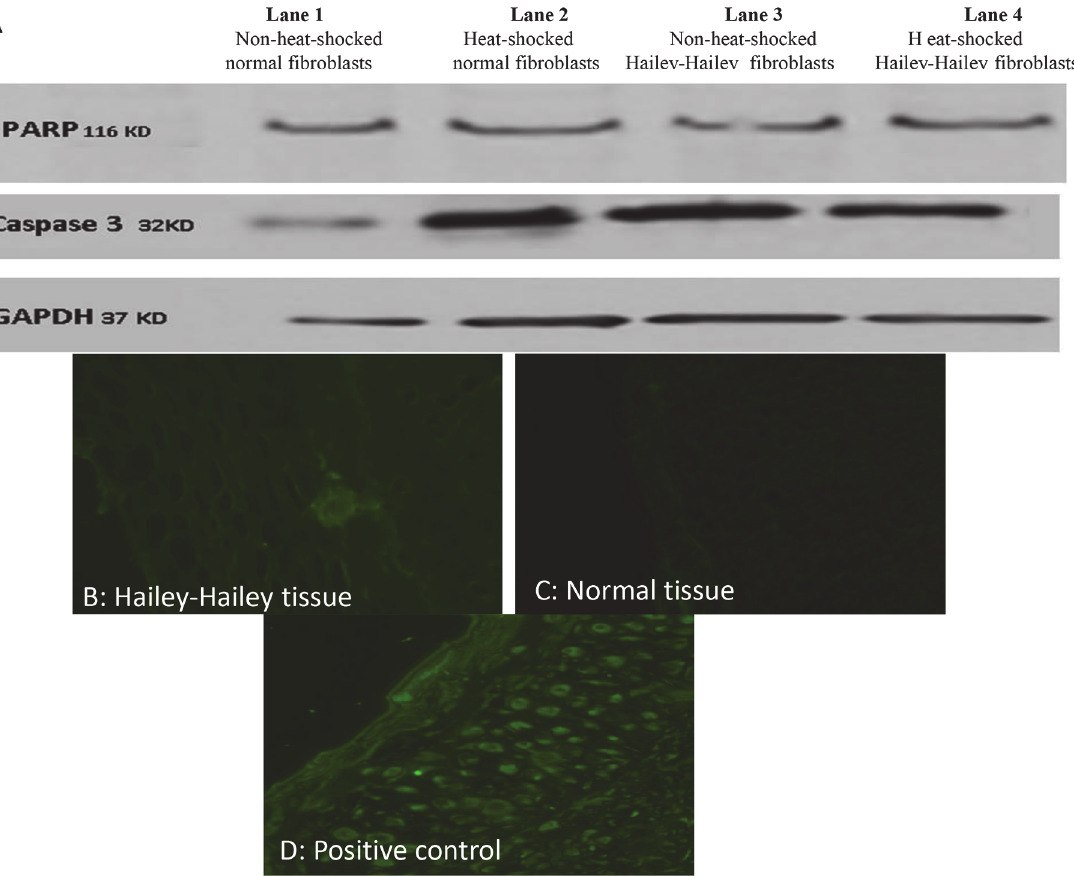
Fig 3. Investigating the role of apoptosis in Hailey-Hailey disease (A) Western blotting against caspase 3 and PARP proteins; lane 1: non-heat- shocked/control normal fibroblasts, lane 2: heat-shocked normal fibroblasts, lane 3: non-heat-shocked Hailey-Hailey fibroblasts, lane 4: Heat- shocked Hailey-Hailey fibroblasts. (B) TUNEL staining on paraffin-embedded tissues taken from affected area of a Hailey-Hailey patient. (C) Normal tissue negative for the TUNEL stain, (D) Positive control revealing apoptotic cells after treatment with DNase.